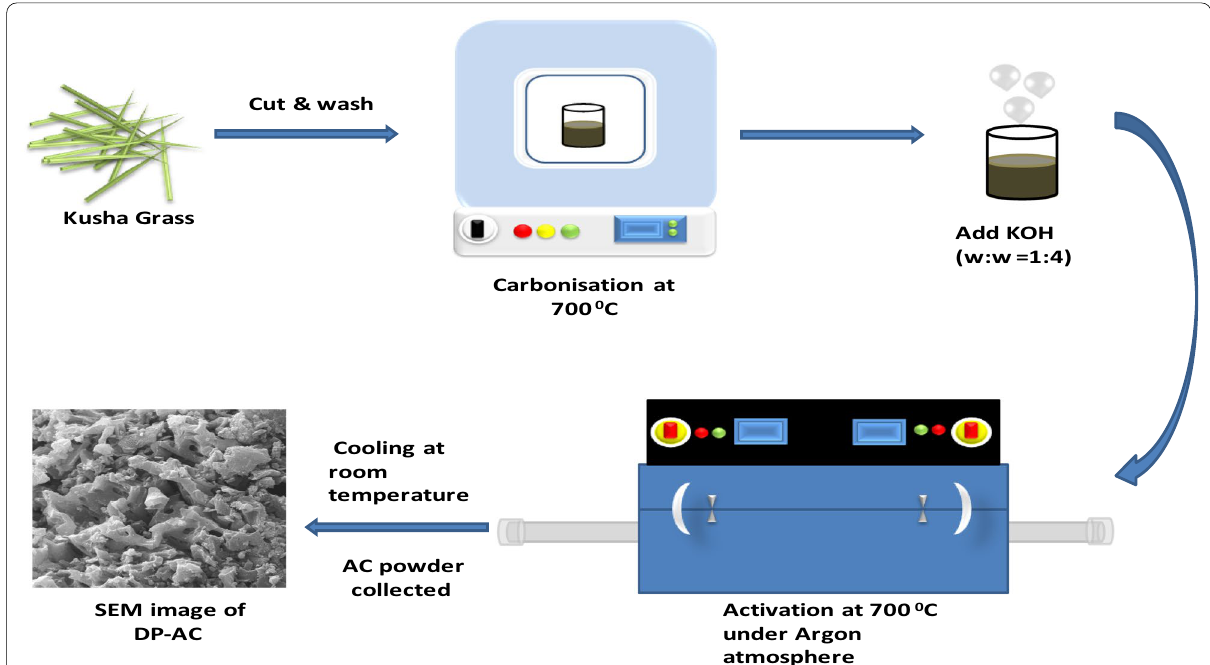
Fig. 1 Illustration of the strategic pathway for the synthesis of activated carbon from Kusha grass ( Desmostachya bipinnata